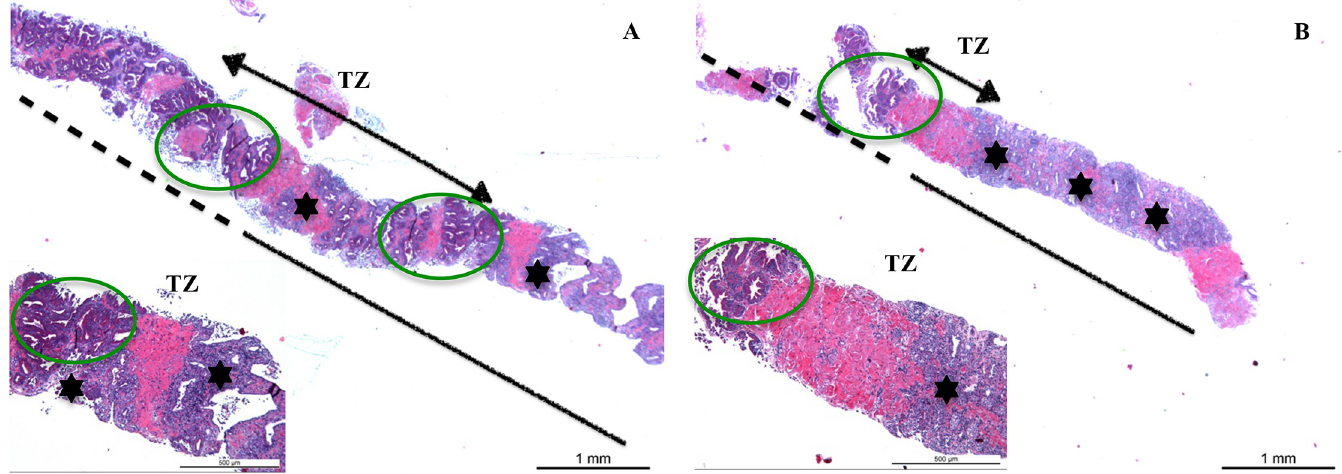
Fig 5. Section of prostate biopsy cores obtained from two healthy beagle dogs 4 weeks after intraprostatic steam application depicting smooth (A) and sharp (B) transition zones (TZ). TZ are represented by a black arrow between treated (continuous black line) and untreated areas (discontinued black line). Areas of inflammation and necrosis (black asterisk) intermingled within normal prostatic tissue (green oval) are noticed in A, whereas a clear interruption of between normal prostatic tissue and areas of inflammation and necrosis are depicted in B. HE staining , magnification 1 . 25x10 .